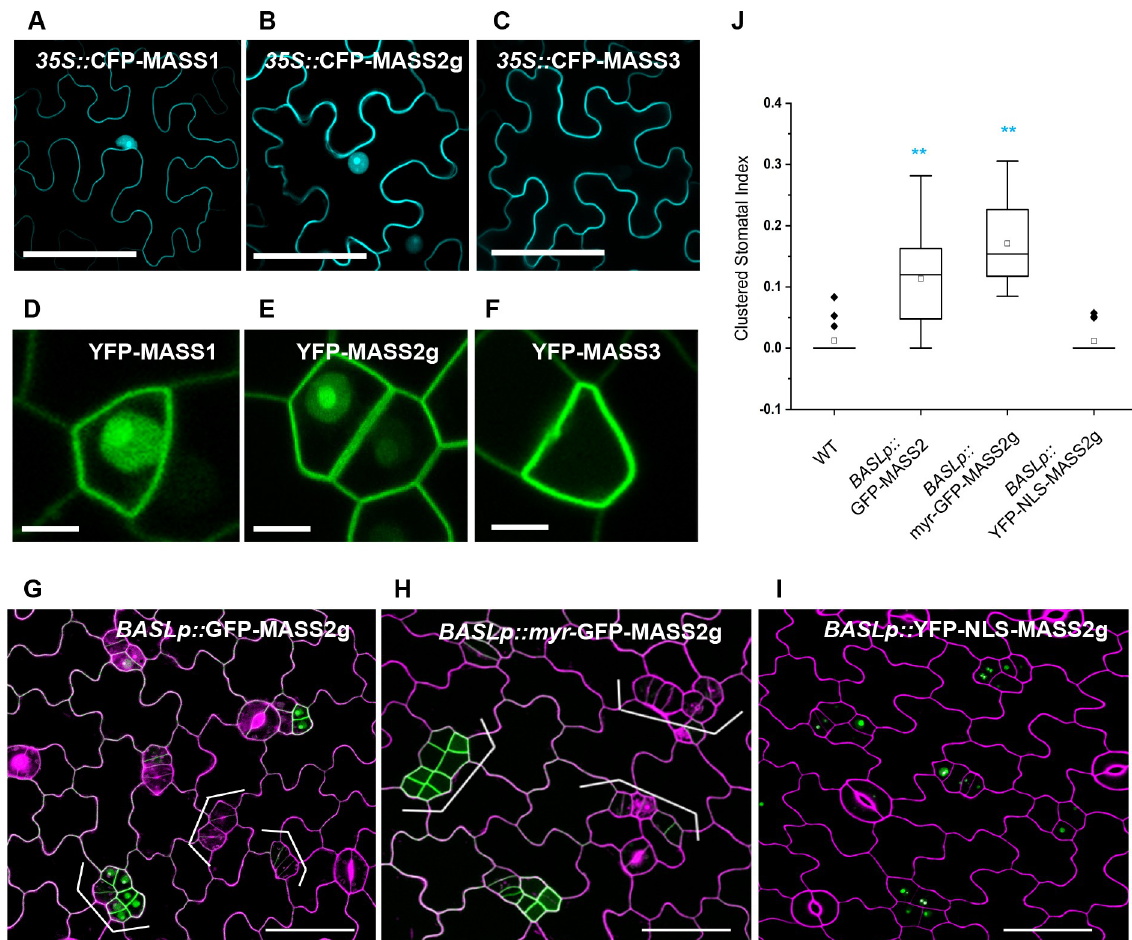
Fig 3. MASS functions at the plasma membrane. (A-C) Protein subcellular localization (cyan) in tobacco epidermal cells leaves. Confocal images of tobacco epidermis transiently expressing CFP-MASS1 (A), CFP-MASS2g (B), and CFP-MASS3 (C), all of which were driven by the 35S promoter. Scale bars represent 50 μ m. (D-F) Protein localization (green) in the stomatal lineage cells in Arabidopsis. Confocal images of 3-dpg adaxial cotyledon epidermis expressing YFP-MASS1 (D), YFP-MASS2g (E), and YFP-MASS3 (F), all driven by the BASL promoter. Scale bars represent 10 μ m. (G-I) Stomatal phenotypes triggered by expressing MASS2 and other variants. Confocal images of 3-dpg adaxial cotyledon epidermis expressing GFP-MASS2g (G), myr-GFP-MASS2g (H), and YFP-NLS-MASS2g (I). Green shows GFP-MASS expression pattern. Scale bars represent 50 μ m. Brackets indicate stomatal clusters and abnormal cell divisions. (J) Index of clustered stomata in 5-dpg adaxial cotyledons of designated plants. Cell outlines in (G-I) were stained with PI (magenta). � significantly different compared the WT (Col) (Student’s t -test, � P < 0.05, �� P <